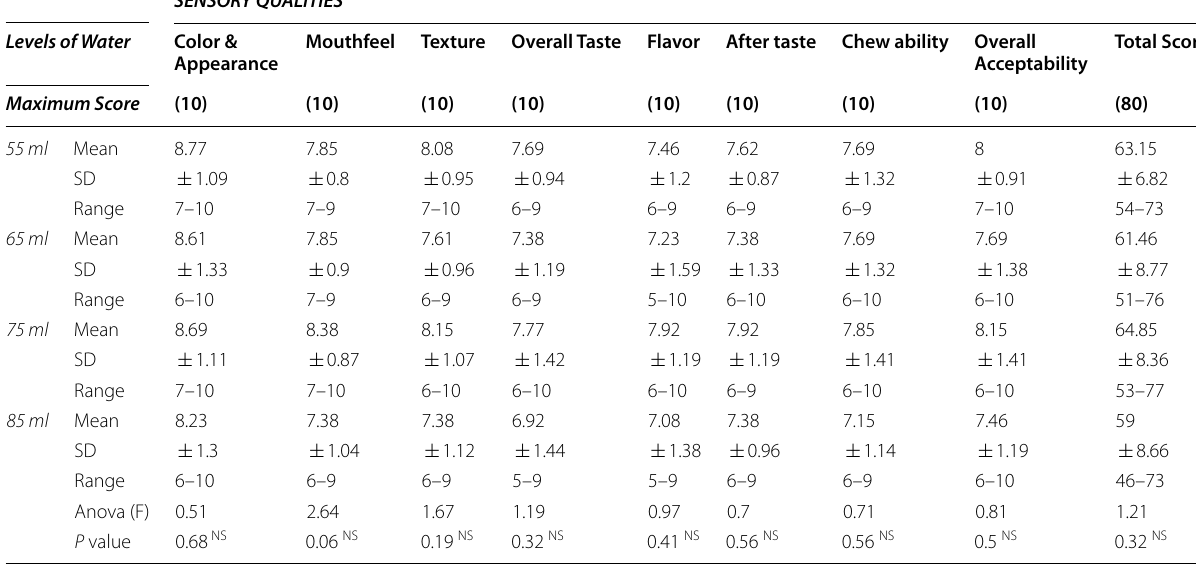
Table 1 Standardization with varying levels of water addition